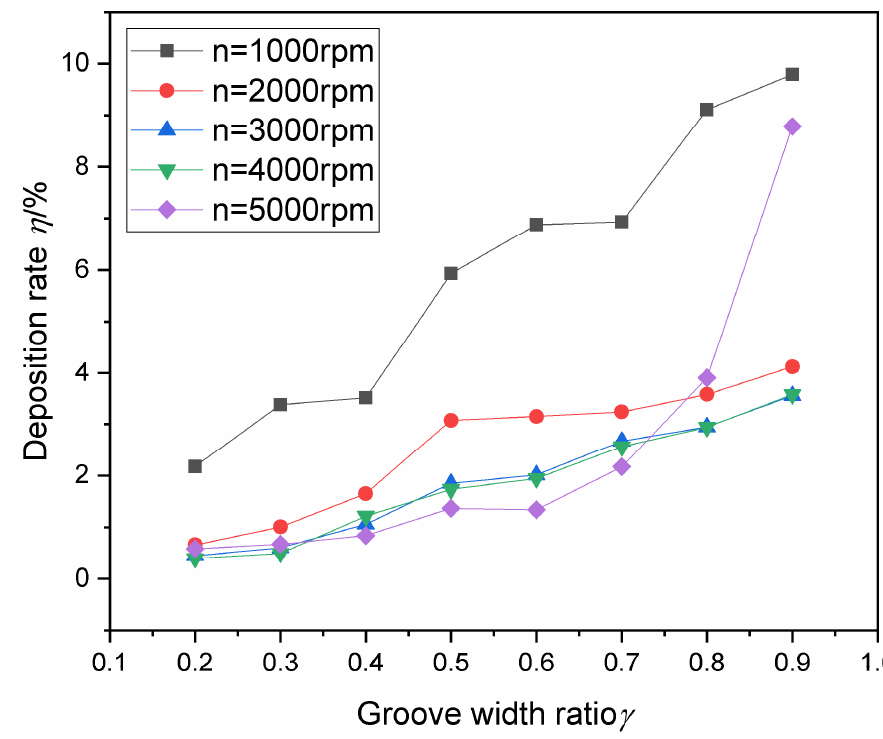
Figure 16. Influence of groove width ratio on the deposition rate.